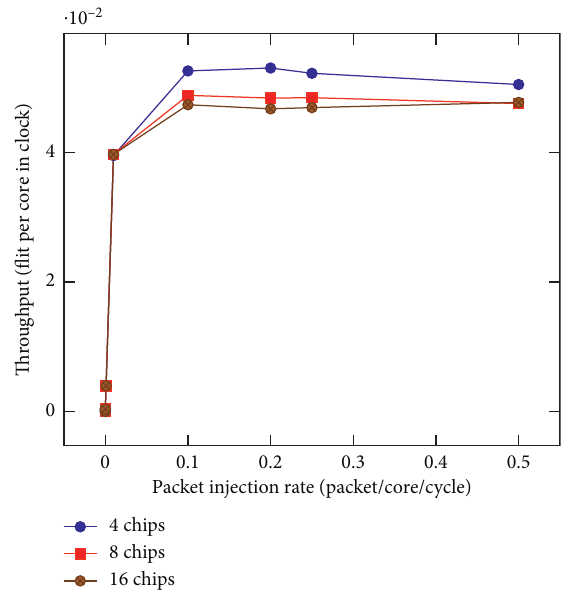
Figure 11: The throughput of the proposed THz multichip system for the different number of chips.